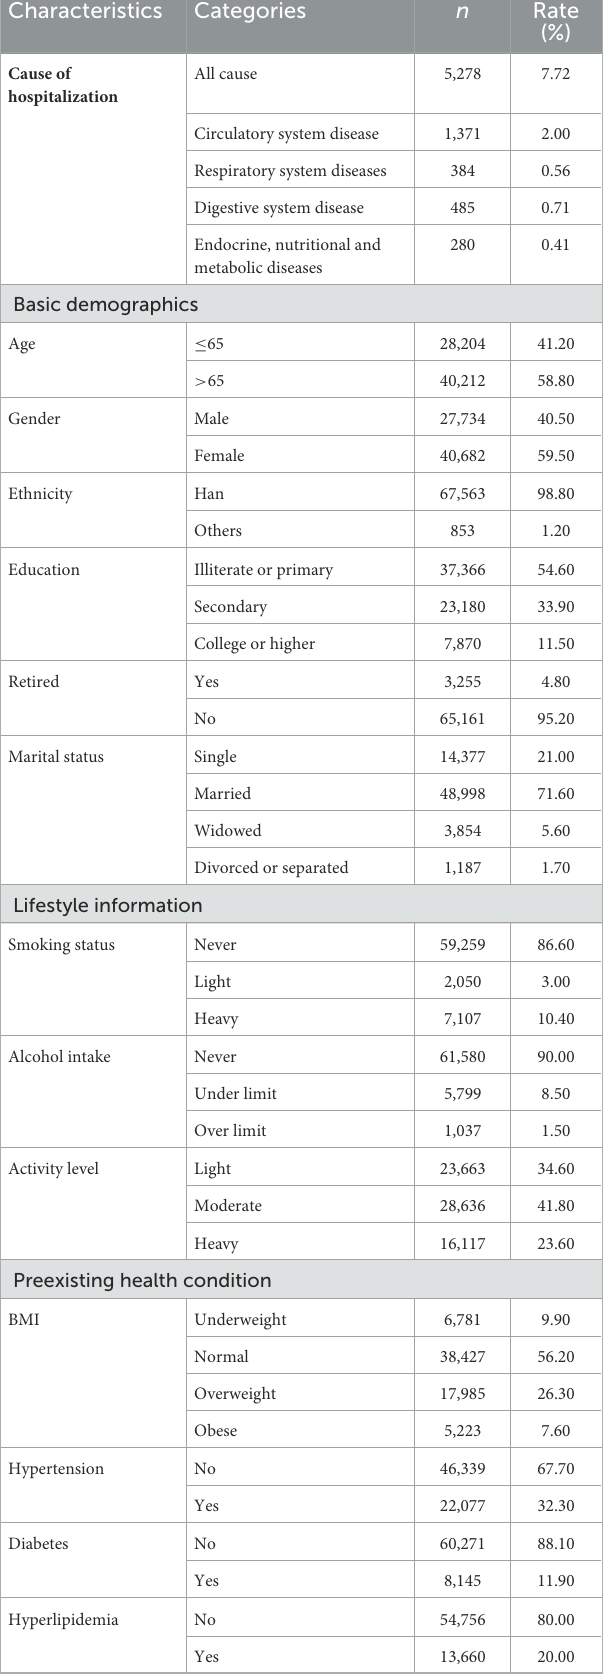
TABLE 1 Characteristics of the study population ( N =